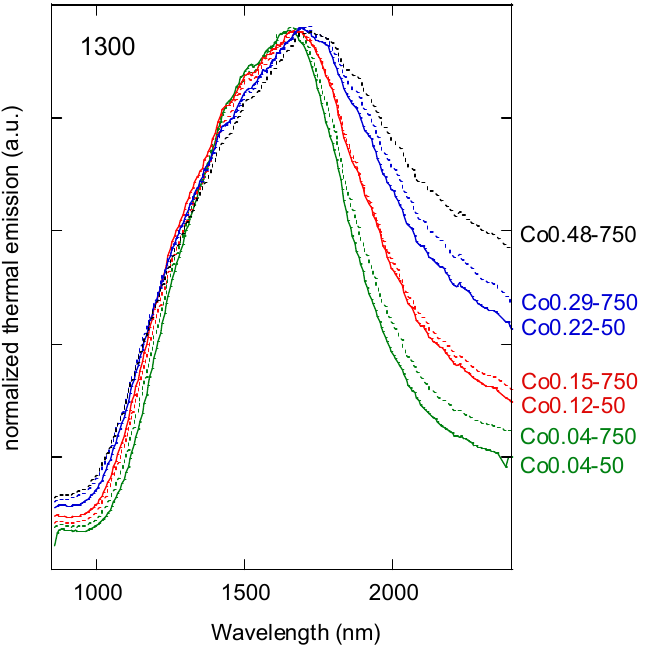
Figure 4. Thermal emission of all the samples grown at 50 mm/h (solid lines) and 750 mm/h (dotted lines) measured at 1300 °C. Spectra, labeled with the sample names (see Table 1), are presented normalized for comparison purposes.